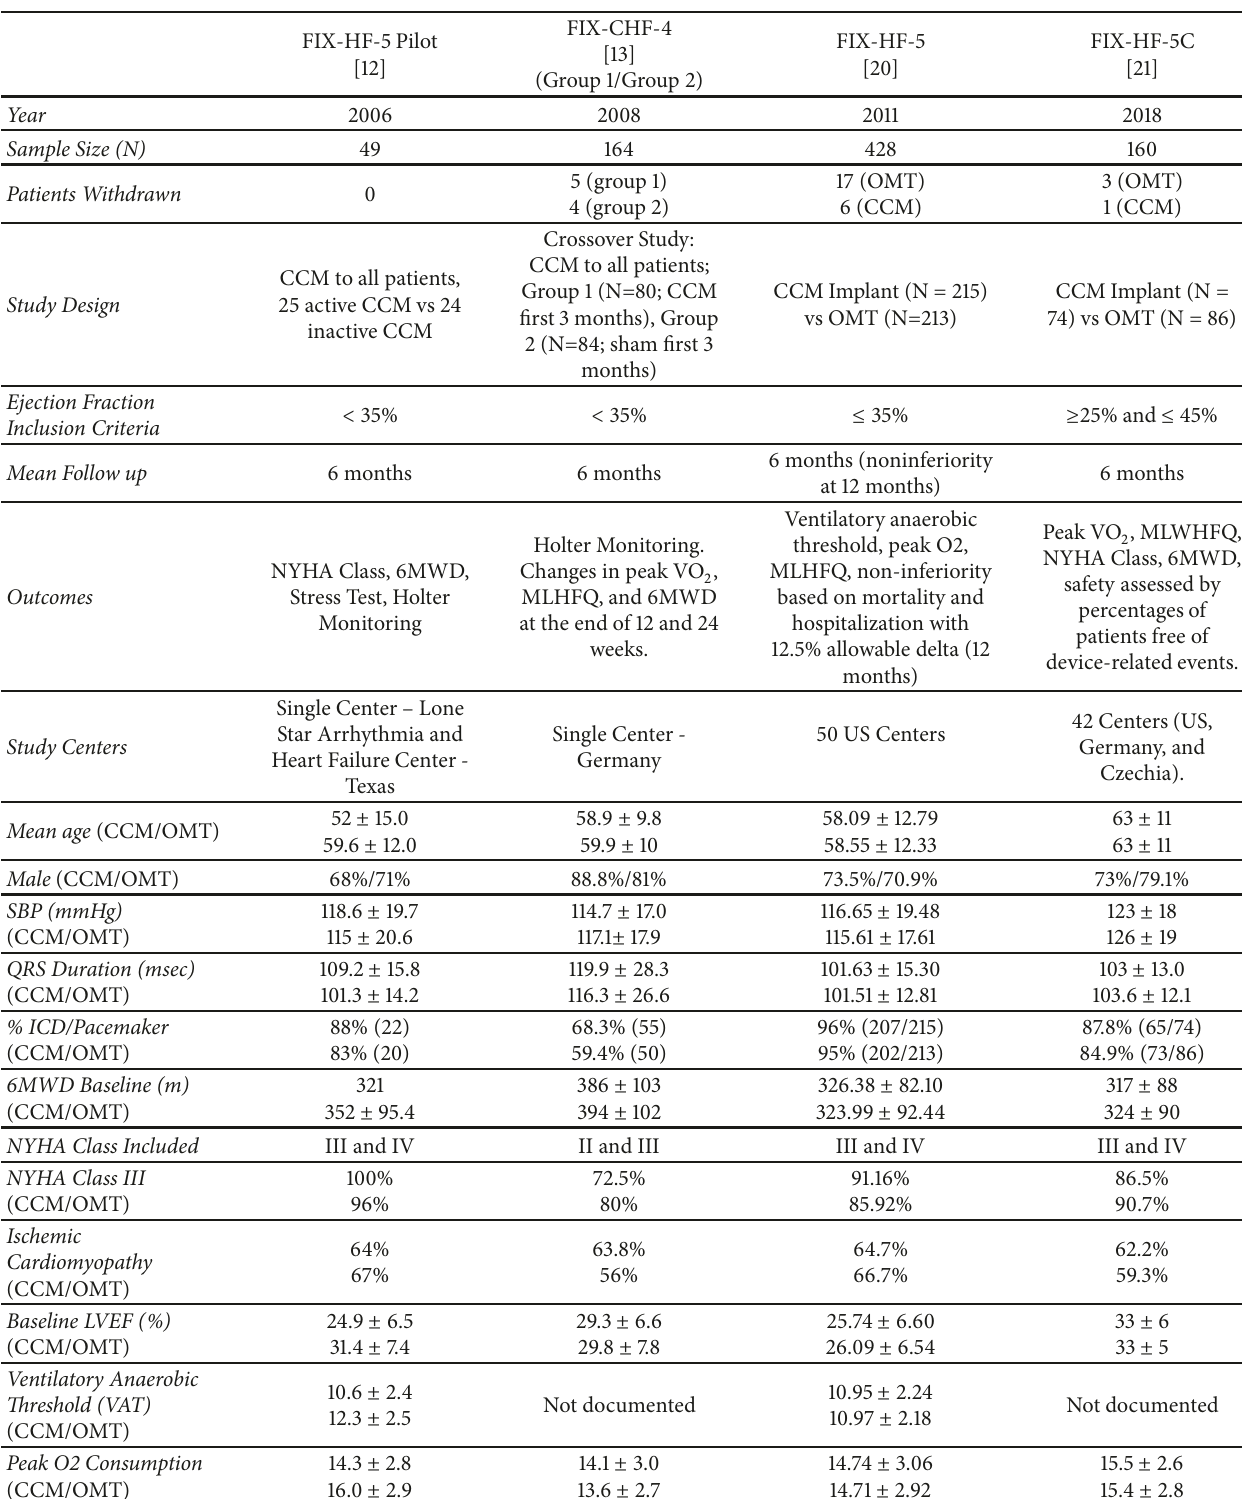
Table 1: Studies characteristics and patient